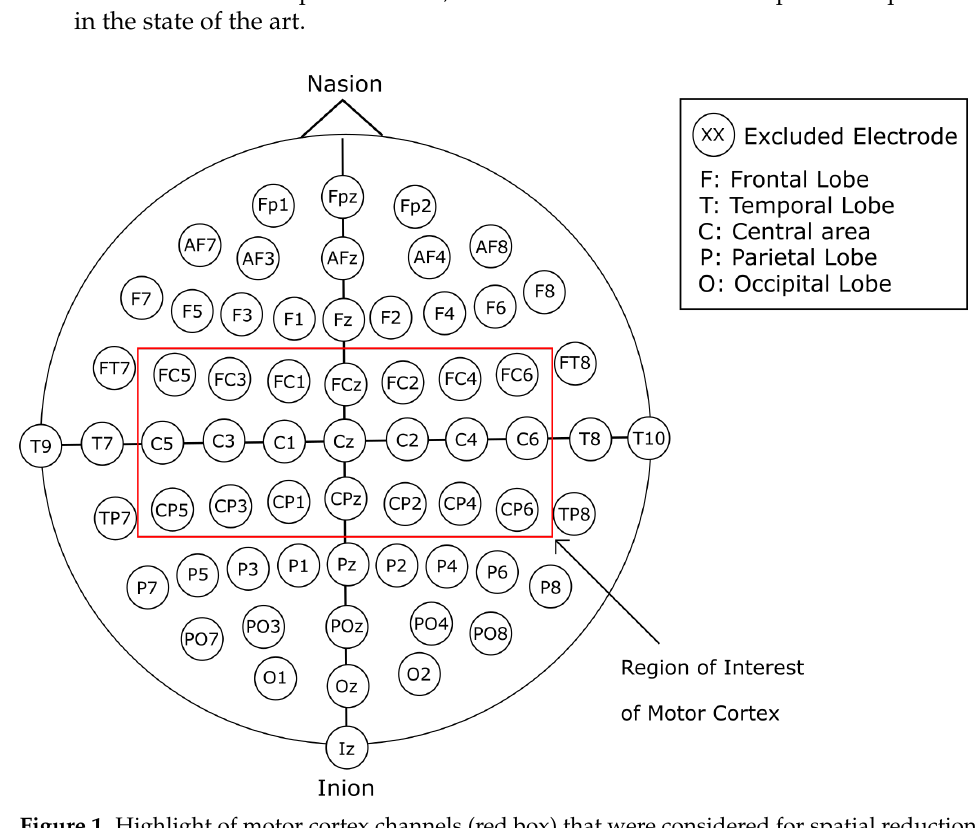
Figure 1. Highlight of motor cortex channels (red box) that were considered for spatial